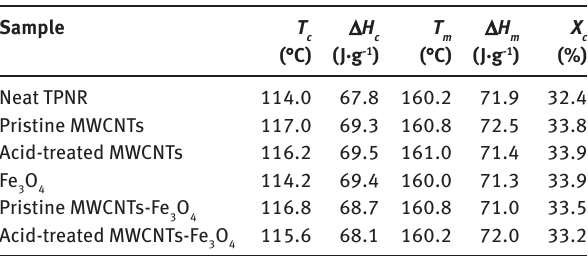
Table 1 Crystallization temperature, crystallization enthalpy, melting temperature, and melting enthalpy of the neat TPNR and its